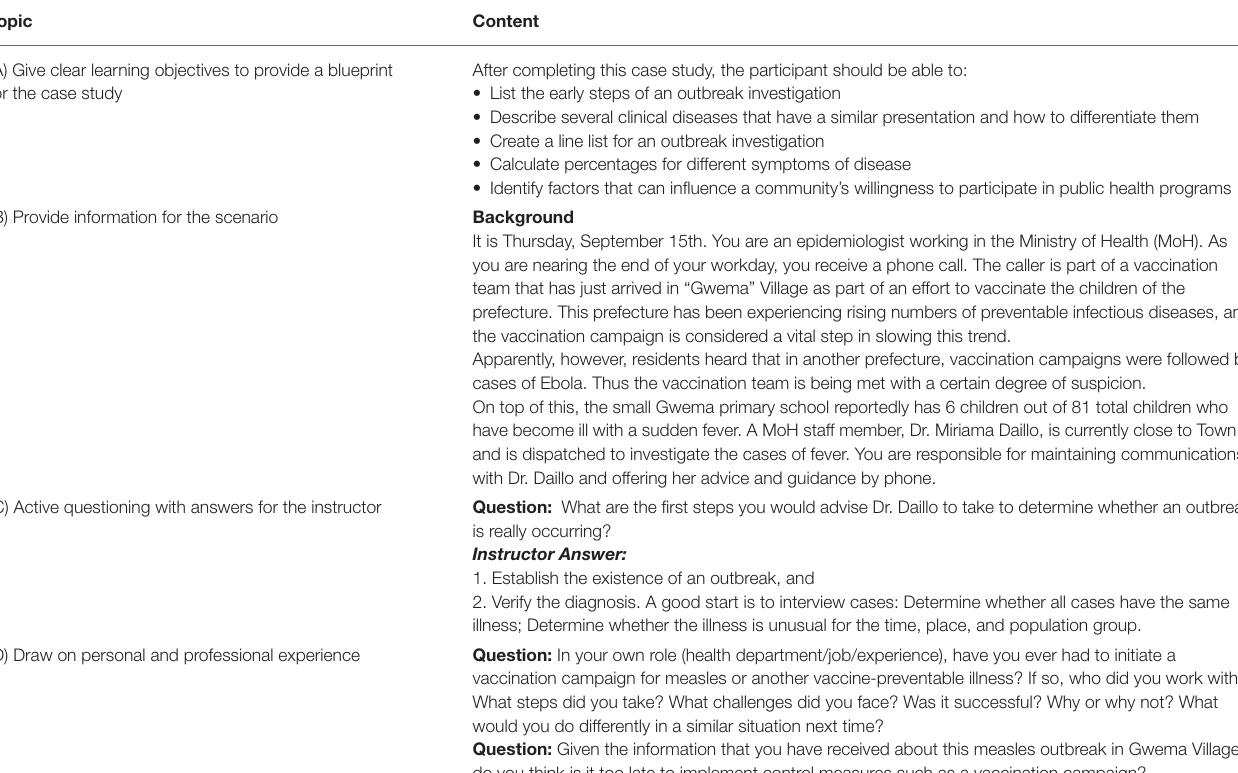
TABLE 3 | Scenario-based examples of a measles outbreak in a small village case study. Topic